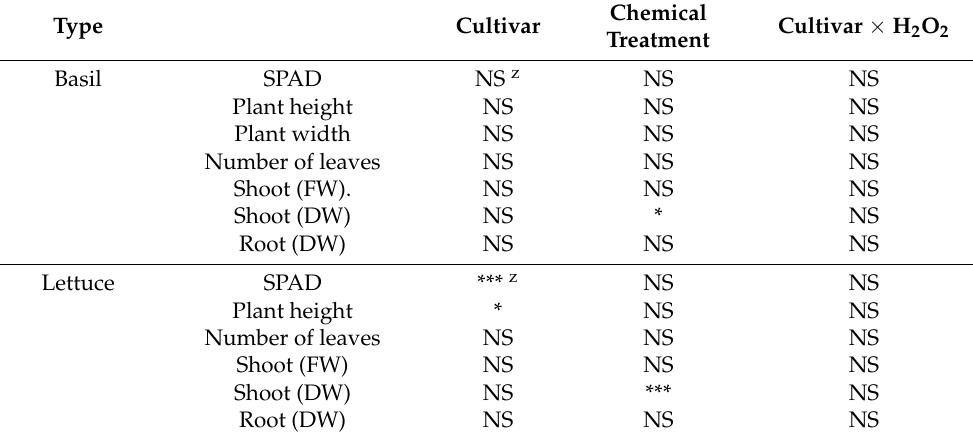
Table 5. Test of effects for hydrogen peroxide treatments and two basil and two lettuce cultivars grown in an ebb and flow hydroponic system at OSU research greenhouses in Stillwater, OK, for experiment 2.